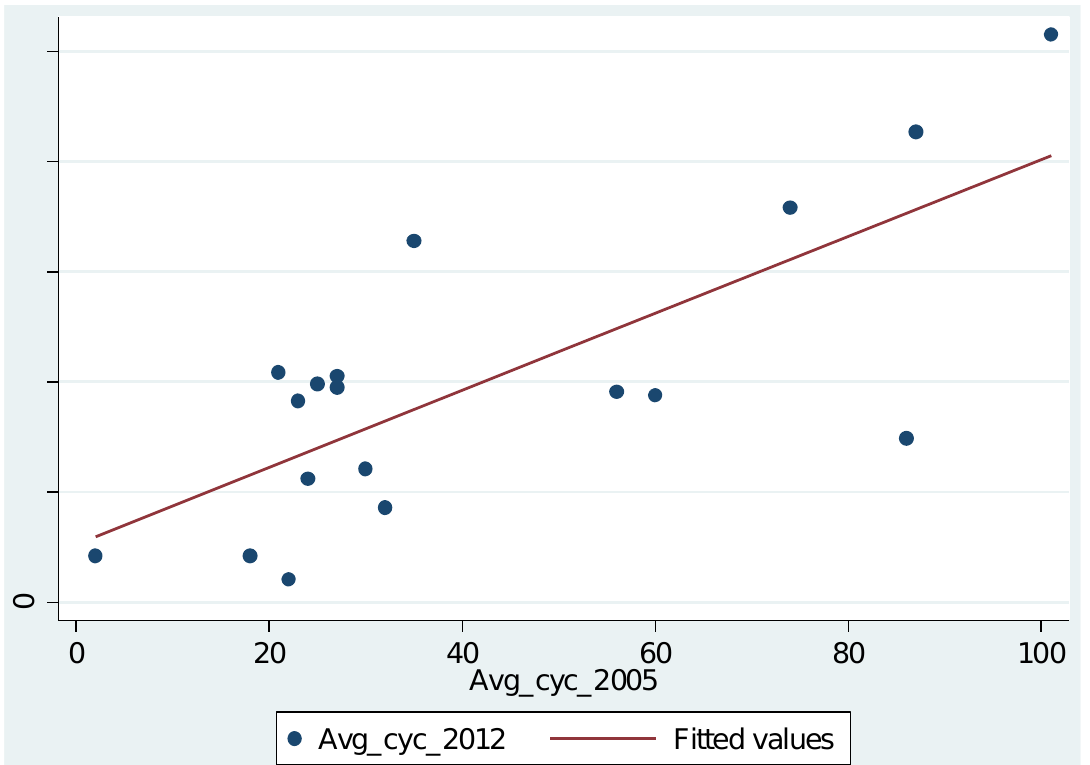
Figure 12. The figure highlights a scatterplot between 2003 and 2012 observed average cyclist